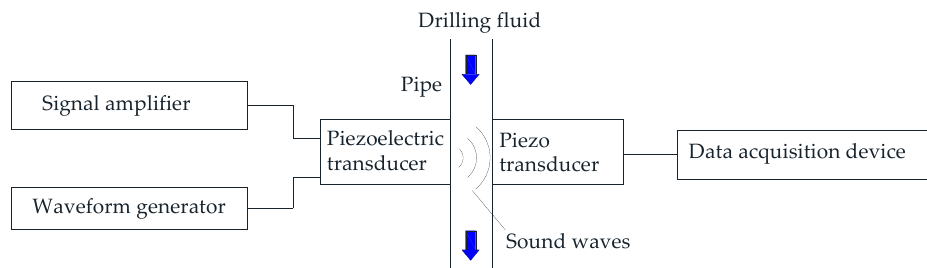
Figure 9. Schematic diagram in Ofoche et al. [74].